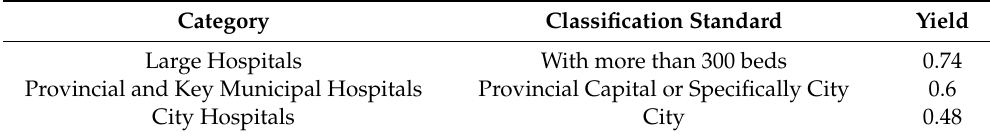
Table 2. The amount of medical waste generated by di ff erent grades of hospitals. Unit: kg / (per bed · per